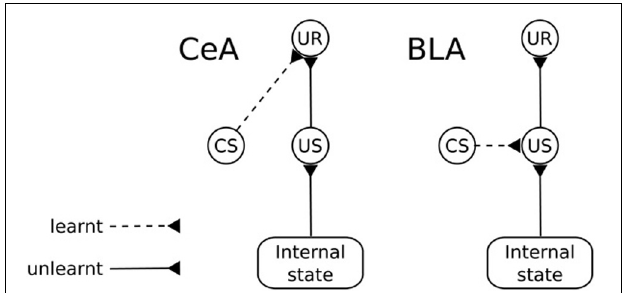
FIGURE 11 | Functional differences between the basolateral amygdala (BLA) and the central nucleus of amygdala (CeA). CS, conditioned stimulus; US, unconditioned stimulus; UR, unconditioned